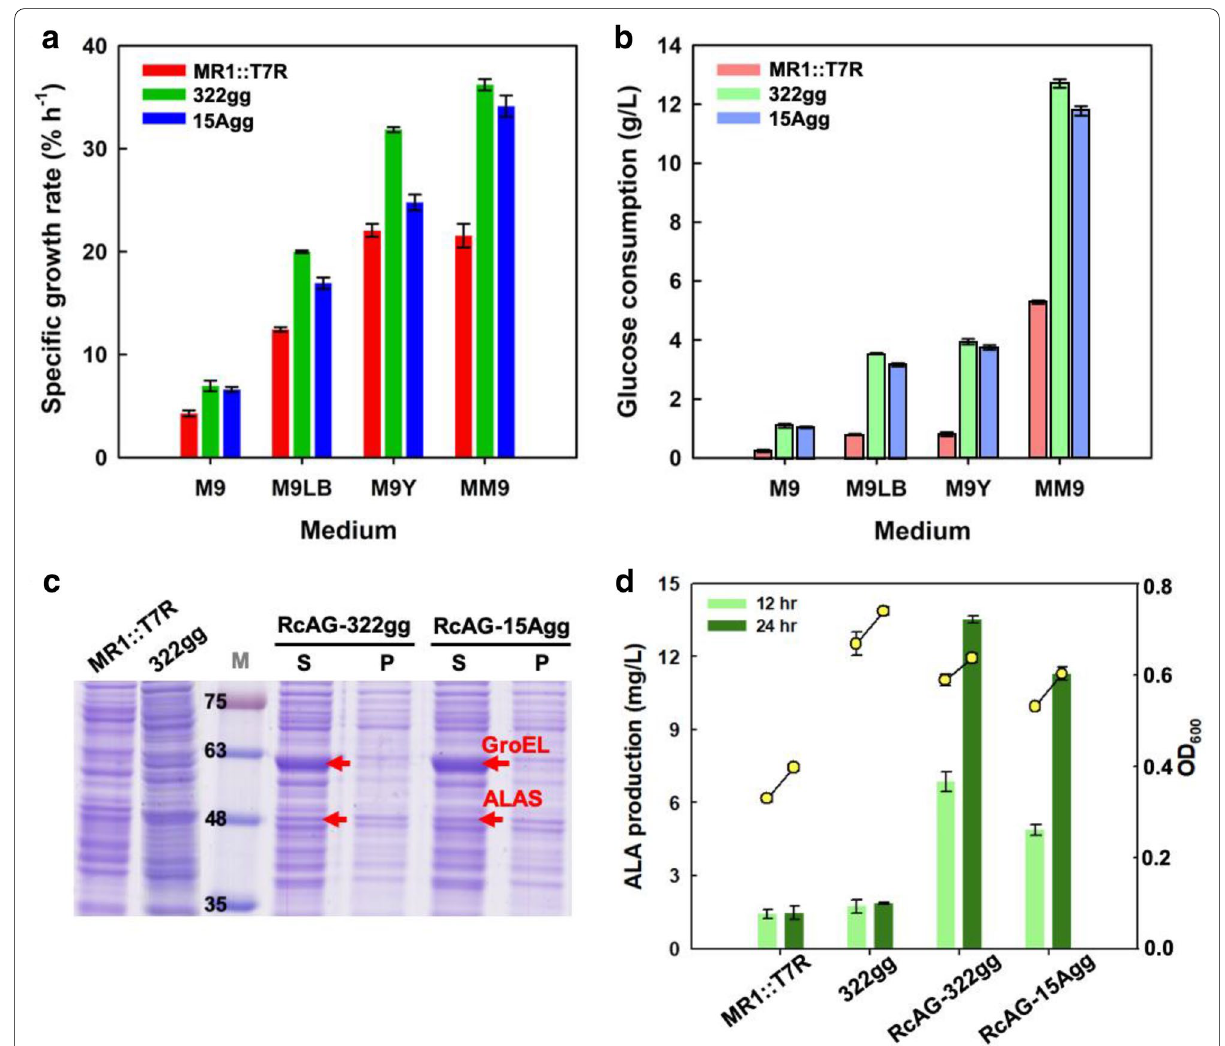
Fig. 6 Characterization of glucose‑consuming strains in different minimal media. MR‑1 cells with medium and low copy numbers for glk-gal P were compared with the wild‑type strain, and the specific growth rates ( a ) and glucose consumption ( b ) were analyzed. ALAS and GroELS were co‑expressed with glk-gal P as two plasmids. c Protein expression was observed by SDS‑PAGE at 12 h, which ALAS and GroEL at sizes of approximately 48 kDa and 63 kDa, respectively. S soluble protein, P insoluble protein, M protein ladder marker. d ALA production and biomass in terms by OD 600 were analyzed at 12 h and 24